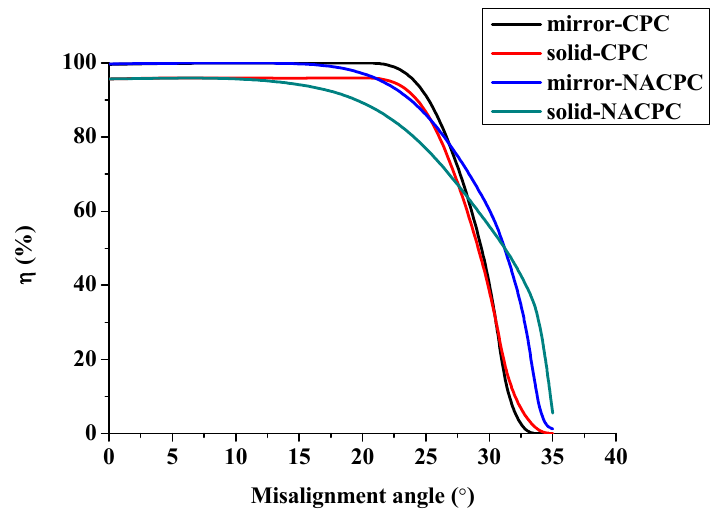
Figure 17. The optical efficiency of the CPC and NACPC.